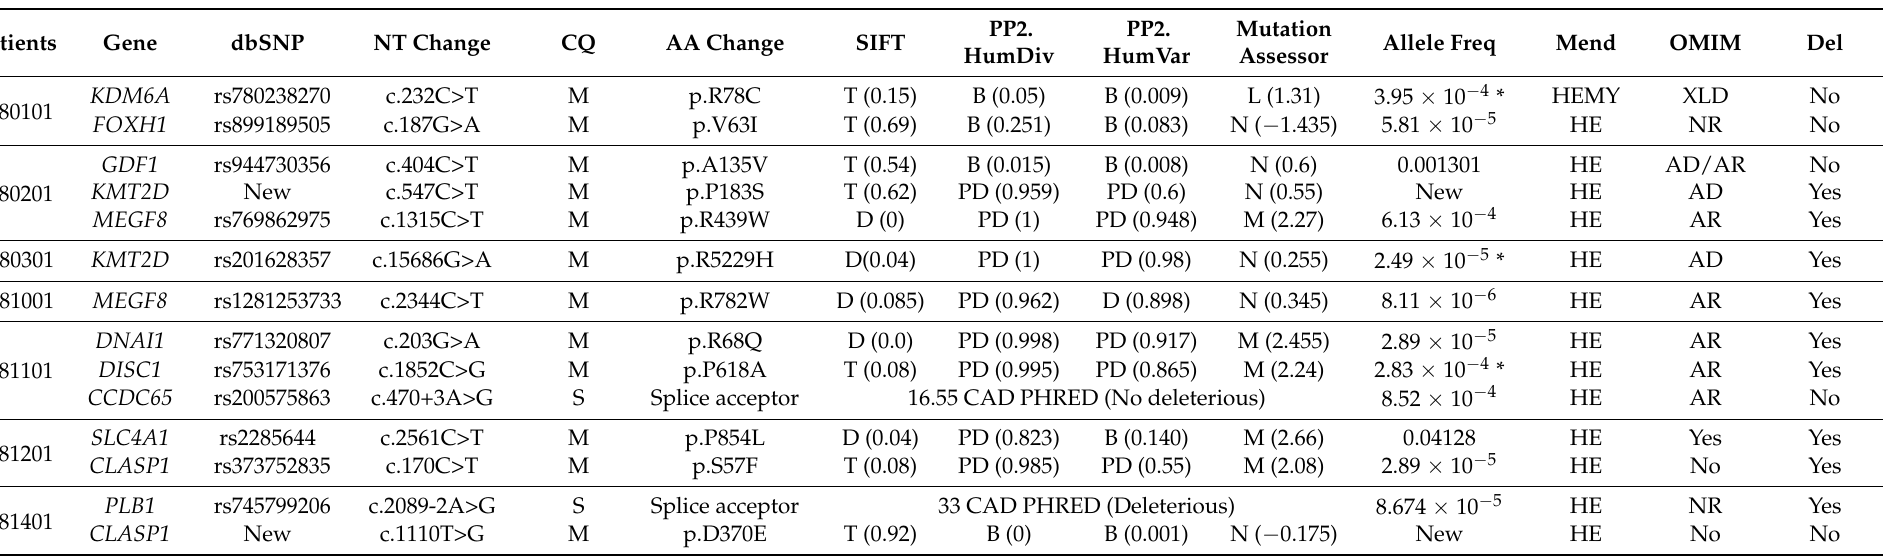
Table 1. Abnormalities in genes previously related to TGA. Missense and splicing anomalies were found in patients with transposition of the great arteries. NODAL/GDF1-DAND5 genetic anomalies are mostly non-deleterious: while other previously cilia-related genes present features of